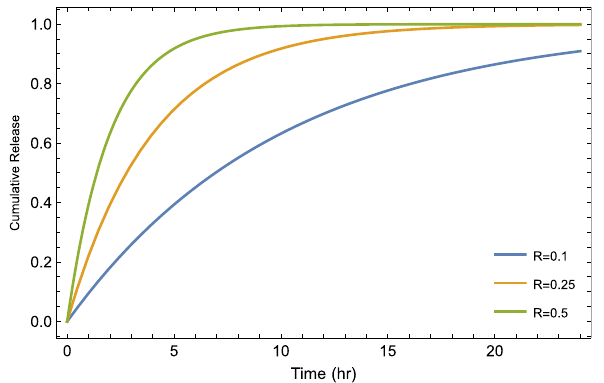
Figure 10. Plot of cumulative drug release given by Eq. 13 for different values of reaction constant at α = 1 and (cid:31) = 0 (refer to the classical first-order kinetic model with different constant rates).